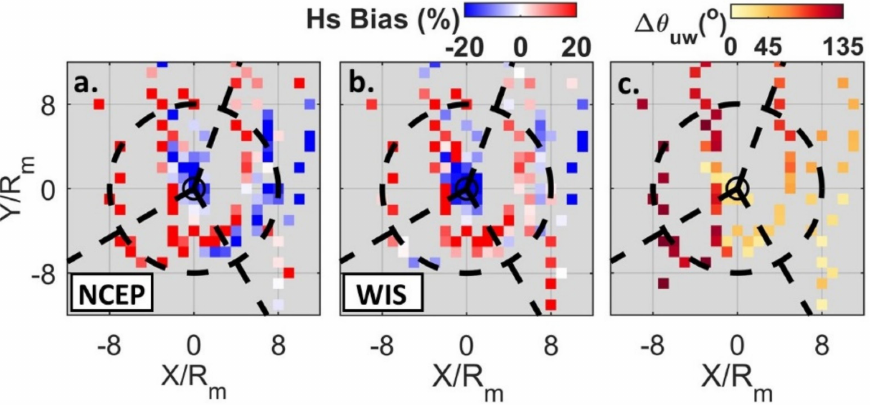
Figure 11. Hs bias at all buoy locations during Hurricane Florence for ( a ) NCEP and ( b ) WIS in a storm-centric frame of reference with distance from the eye normalized by the radius of maximum winds (Rm). ( c ) Difference between dominant wave direction and wind direction ( θ uw ). Observations were binned into 1 Rm × 1 Rm bins. The inner circle denotes 1 Rm and outer dotted circle denotes 8 Rm. Direction of storm motion is up the